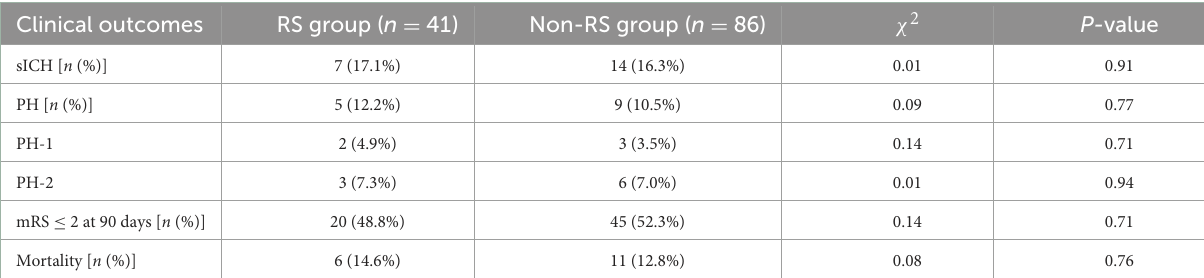
TABLE 2 Comparison of clinical outcomes among the two